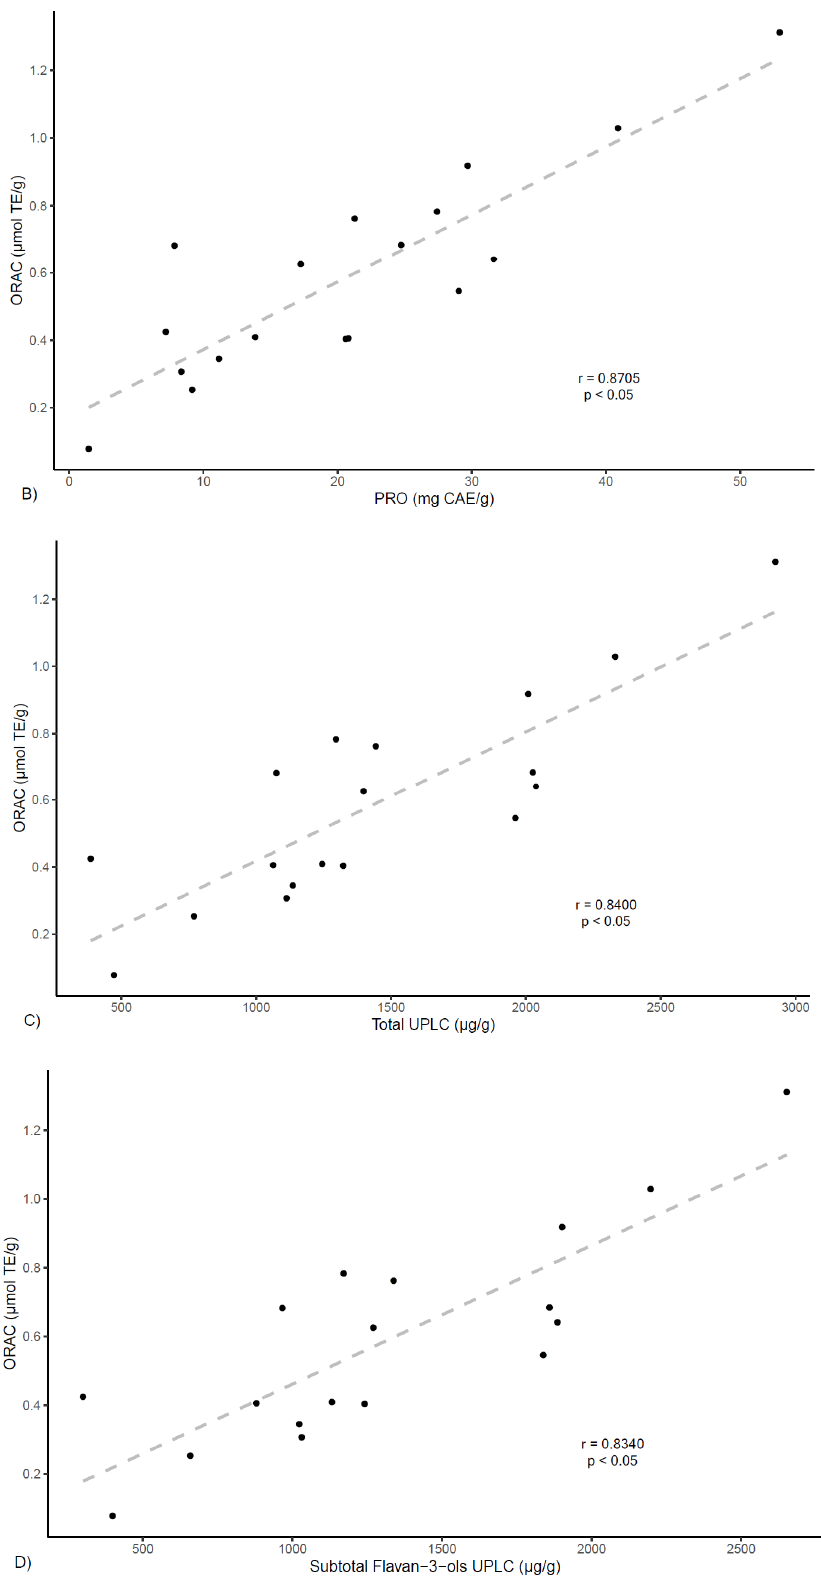
Figure 4. Correlation of antioxidant scavenging activity assessed by the ORAC method with ( A ) Flavan-3-ols by PRO; ( B ) TP by Folin-Ciocalteau; ( C ) Flavan-3-ols by UPLC; and ( D ) TP by UPLC.